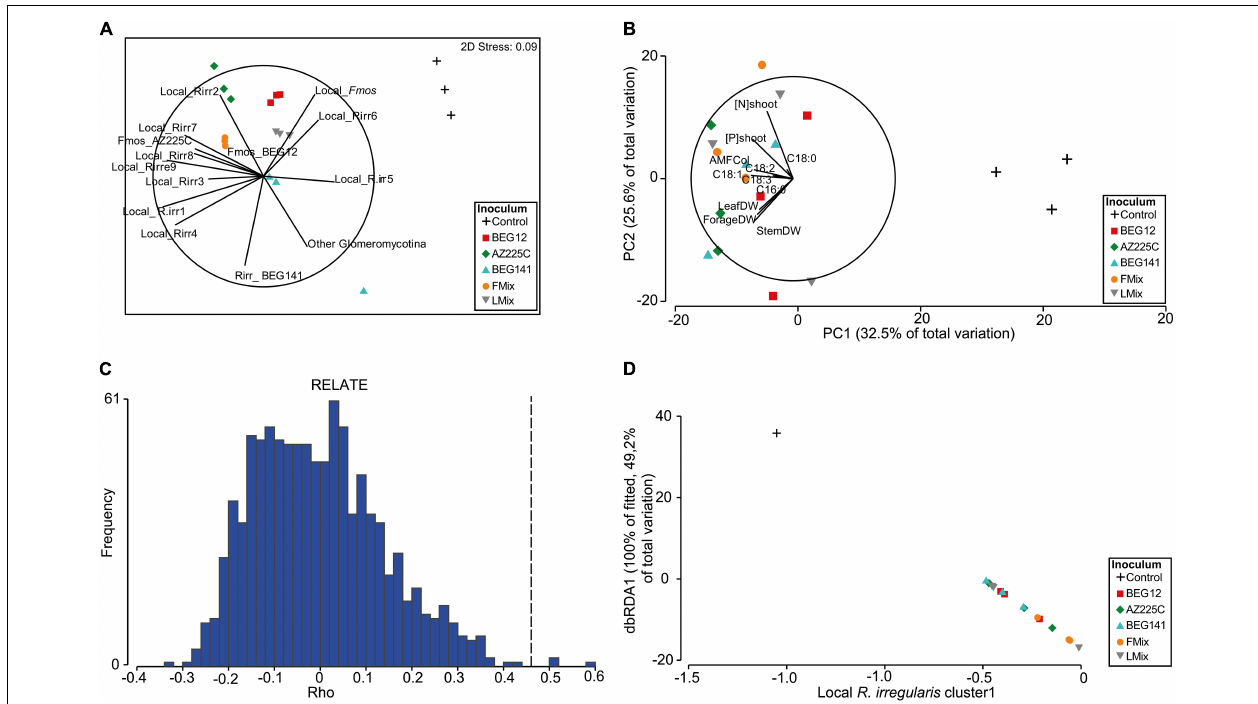
FIGURE 6 | Non-metric multidimensional scaling analysis (nMDS) plot based on the Bray-Curtis similarity matrix calculated on the fourth-root AM fungal relative abundances of phylotypes retrieved within the roots of inoculated and not-inoculated 2-year alfalfa (A) . A principal component analysis (PCA) plot was performed on the Euclidian distance matrix calculated on the square root of the plant traits (plant growth, N and P concentration of forage, and fatty acid composition) (B) . RELATE analysis based on Spearman rank and 999 permutations for testing the significance of the relationship between the two matrices (C) . Distance-based redundancy analysis plot used to visualize the first and second axes of the Distance-based linear method (DistLM) analysis applied to measure the significance and the variance explained by the best descriptor (D)